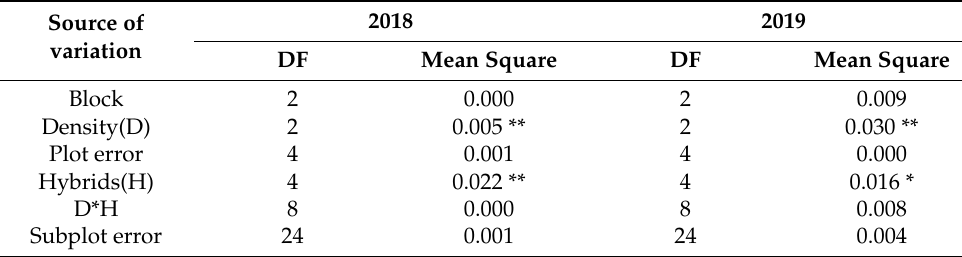
Table 7. ANOVA analysis of seed dehydration rate after physiological